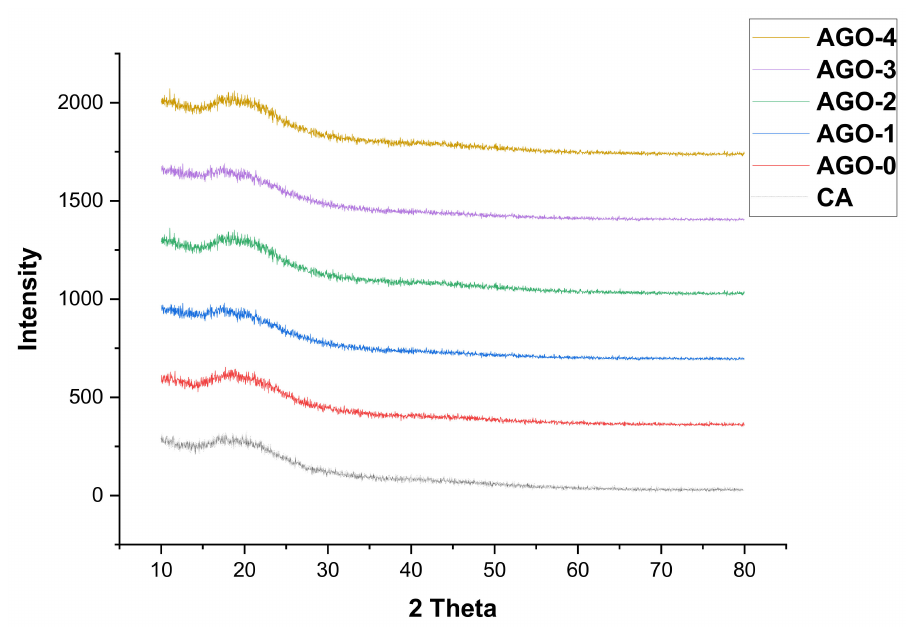
Figure 4. XRD of AGO membranes.